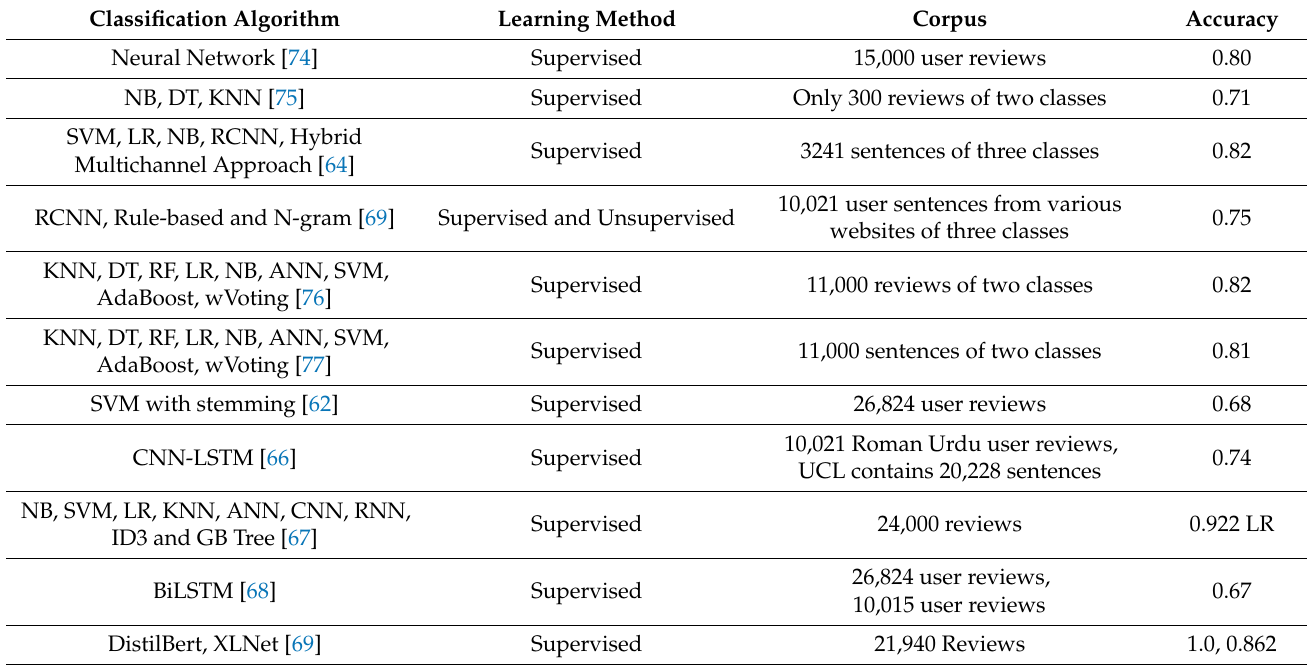
Table 1. Summary of Existing